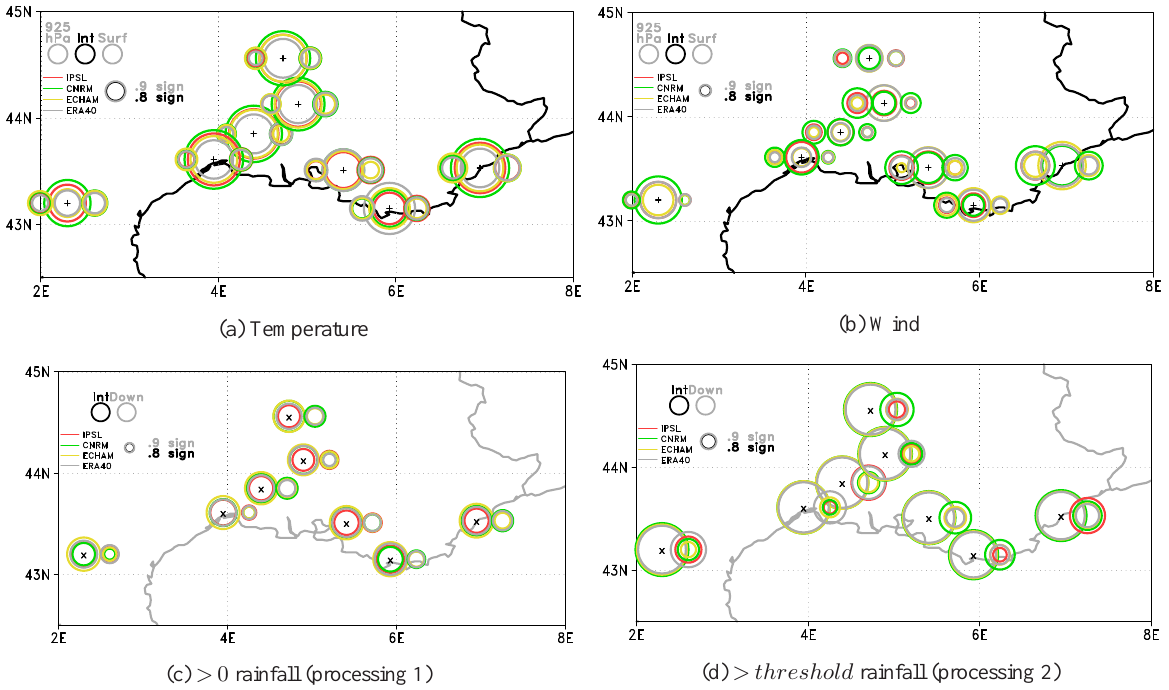
Fig. 3: KS values computed for the validation period between the CDFs of the observed data and the CDFs of the interpolated GCM data (center circles), or the downscaled CDFs using the 925 hPa field (for temperature and wind speed, left circles) or the surface fields (right circles), for (a) temperature, (b) wind, (c) > 0 rainfall from processing 1, and (d) threshold rainfall from processing 2 (see text for details). The color of the circles indicates the source of the large-scale fields: IPSL (red), CNRM (green), ECHAM5 (yellow), and ERA40 (grey). The areas of the circle are proportional to the value of the KS score.